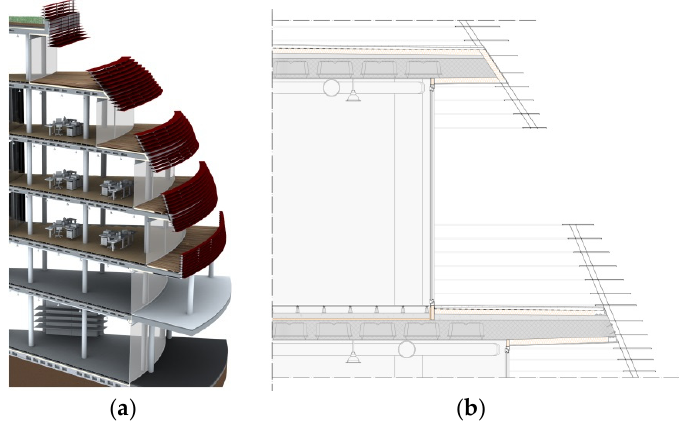
Figure 1. Case study: ( a ) isometric view of the building; ( b ) cross section of the building.